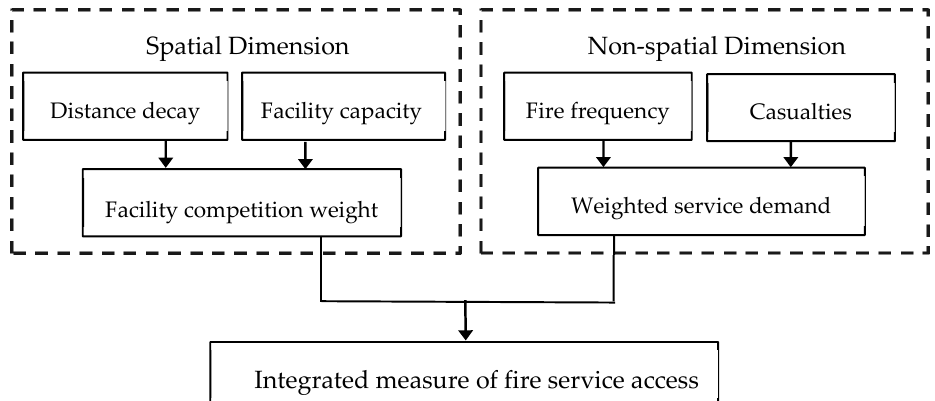
Figure 1. Spatial and non-spatial factors affecting fire service access.